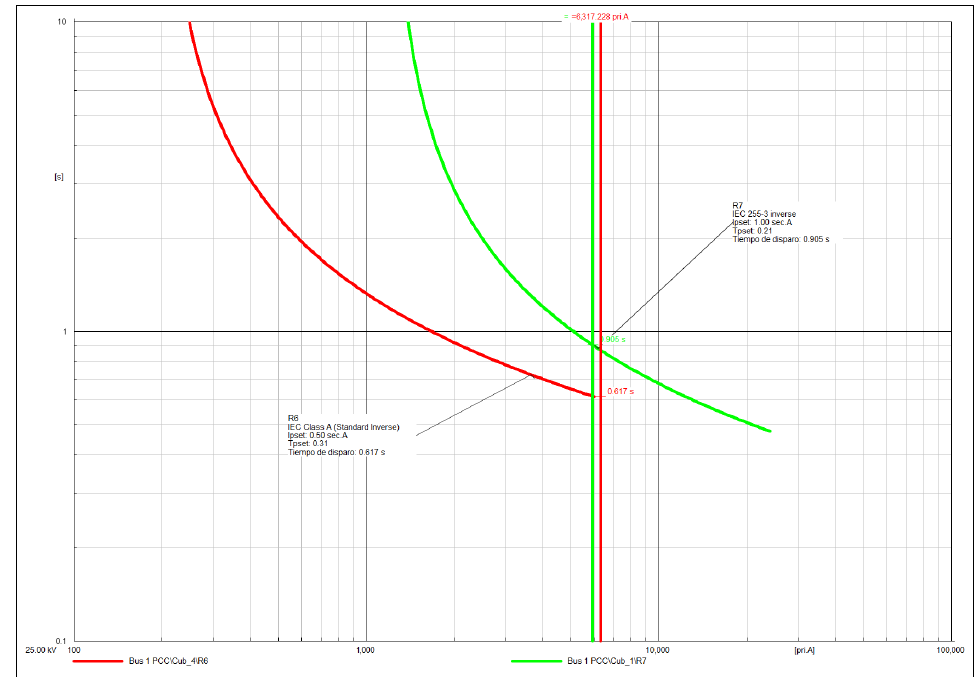
Figure 13. Coordination curve R7–R6 line fault DL-3 scenario EV1.